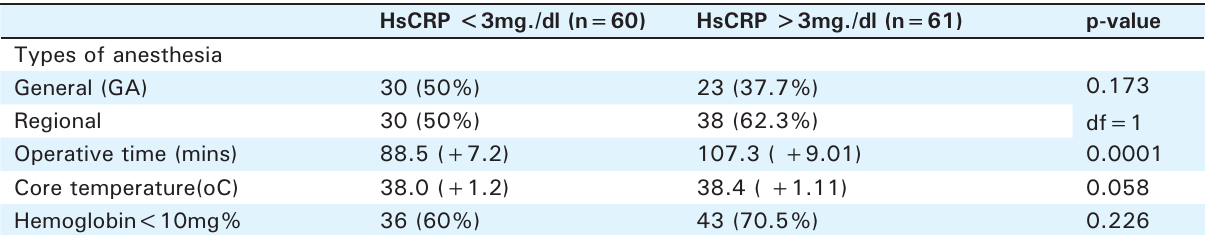
Table 3. Peri-operative relevant details of the study subjects grouped according to hsCRP level < or> 3mg /dl